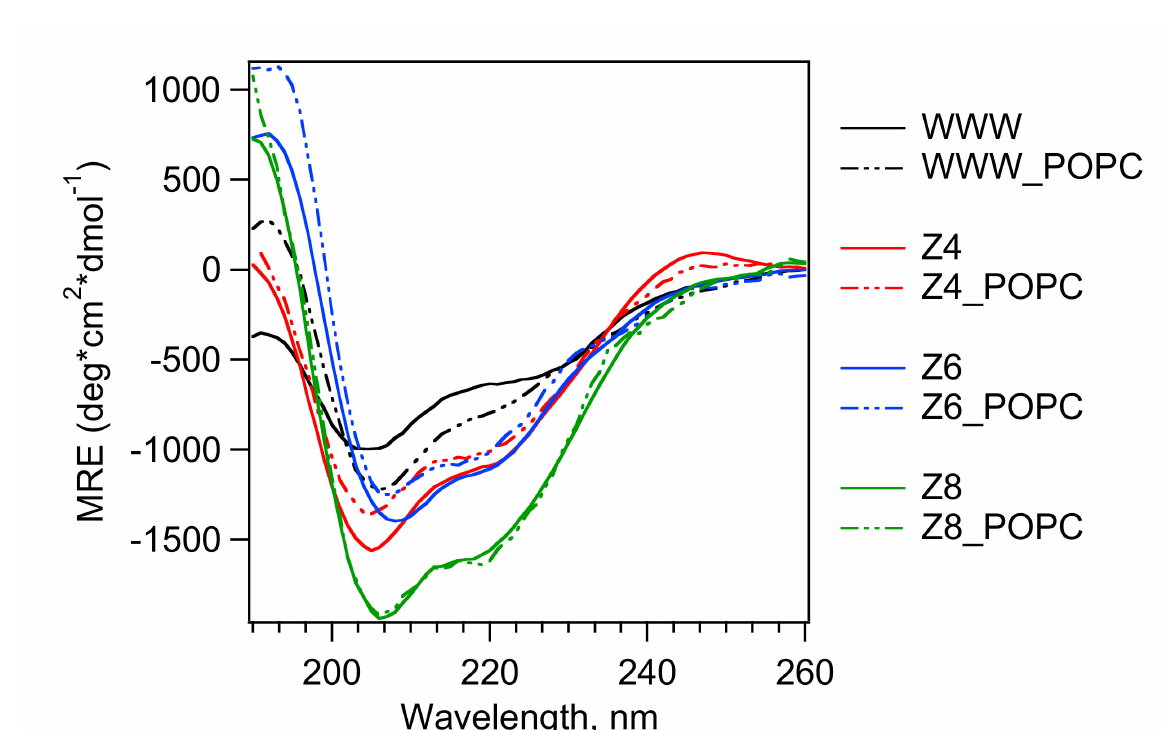
Figure 3. Circular dichroism (CD) spectra of peptides without (solid line) and with POPC lipid (dotted line). Conditions: [peptides] = 5 µ M, [POPC] = 250 µ M, buffer = 5 mM phosphate, 10 mM NaCl, pH